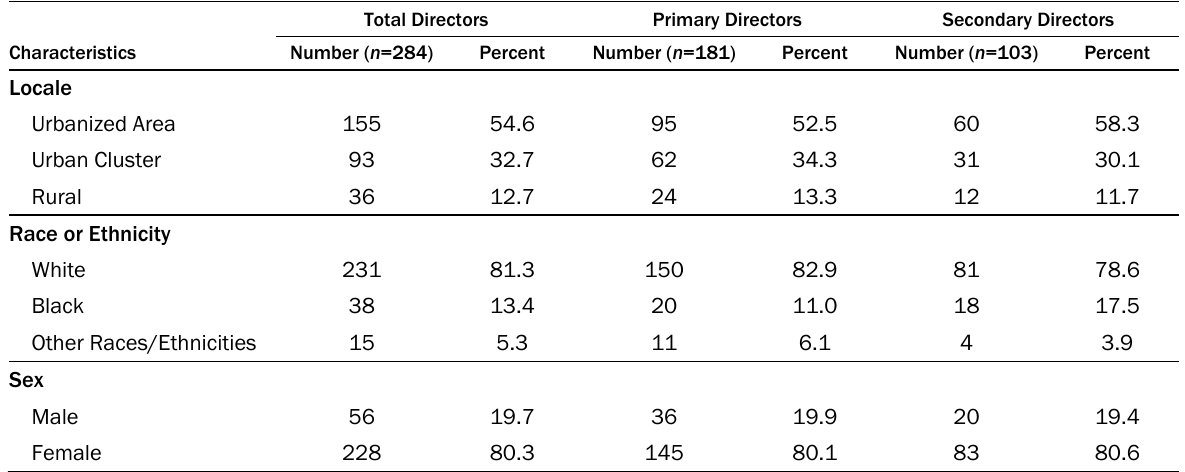
Table 2. Characteristics of the Directors of Emergency Food Assistance Organizations